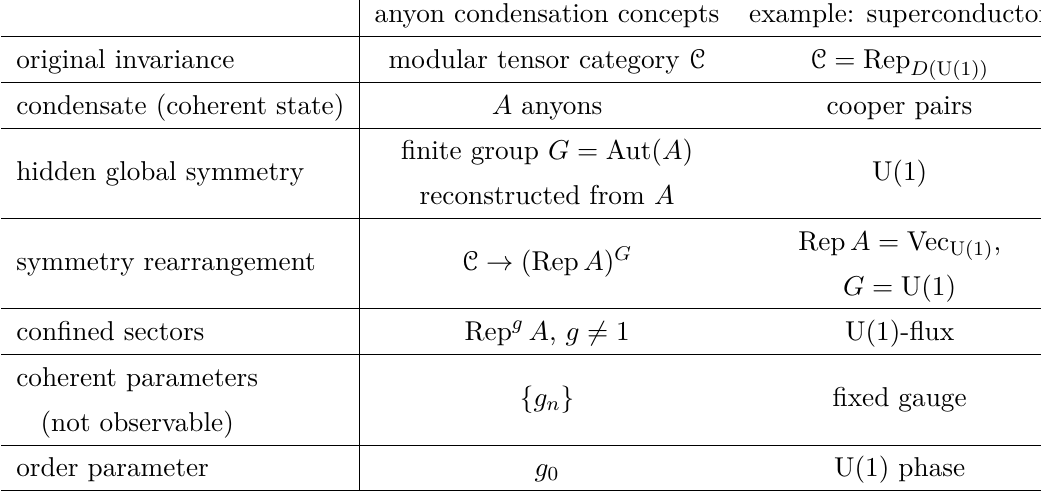
Table 1 . Superconductor as an example of anyon